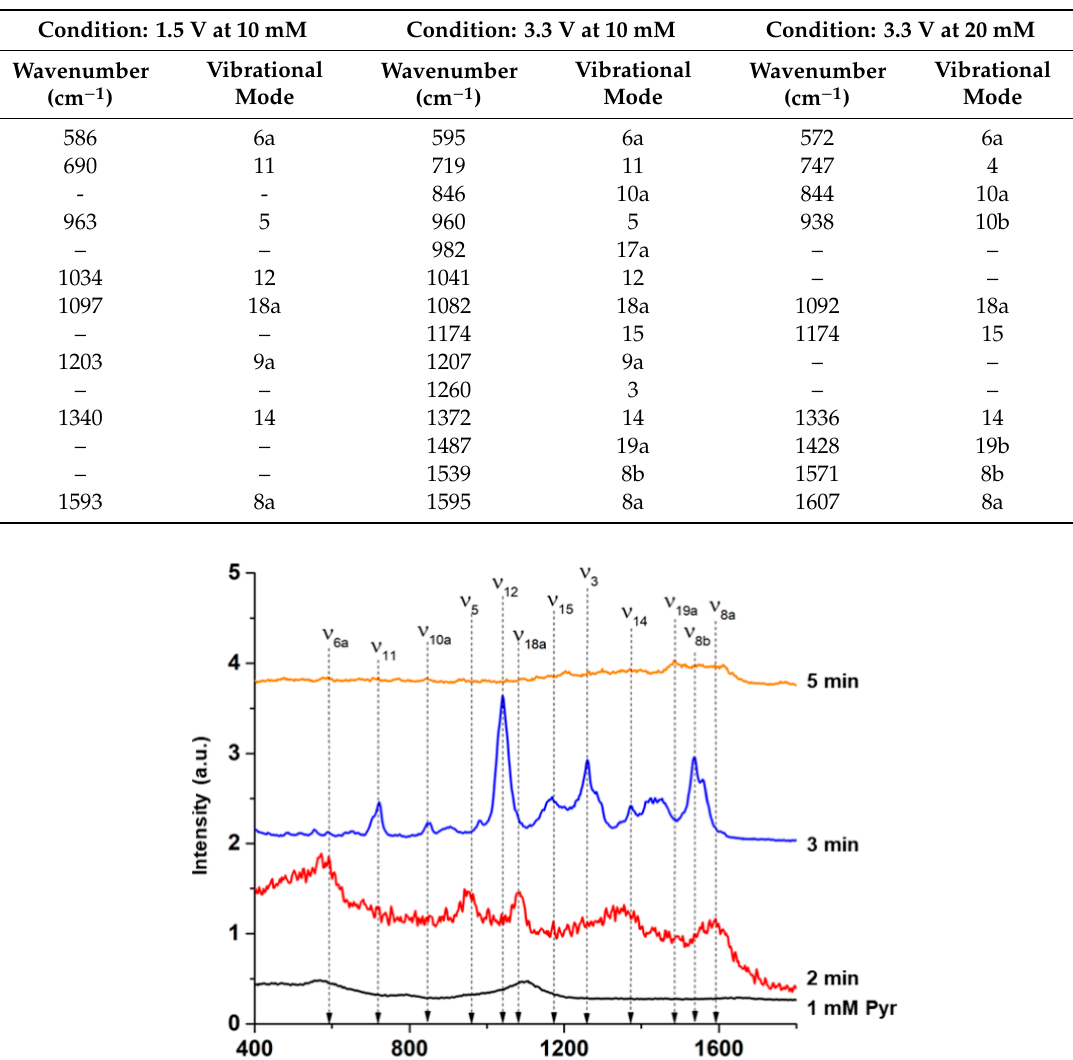
Table 4. Main Raman bands and their corresponding vibrational modes of a 1 nM pyridine solution placed on SiO 2 –HA doped with a 10 mM AgNO 3 solution during di ff erent time intervals (2, 3 and 5 min) using 1.5 and 3.3 V at 10 mM of AgNO 3 ; and 3.3 V at 20 mM of AgNO 3 .